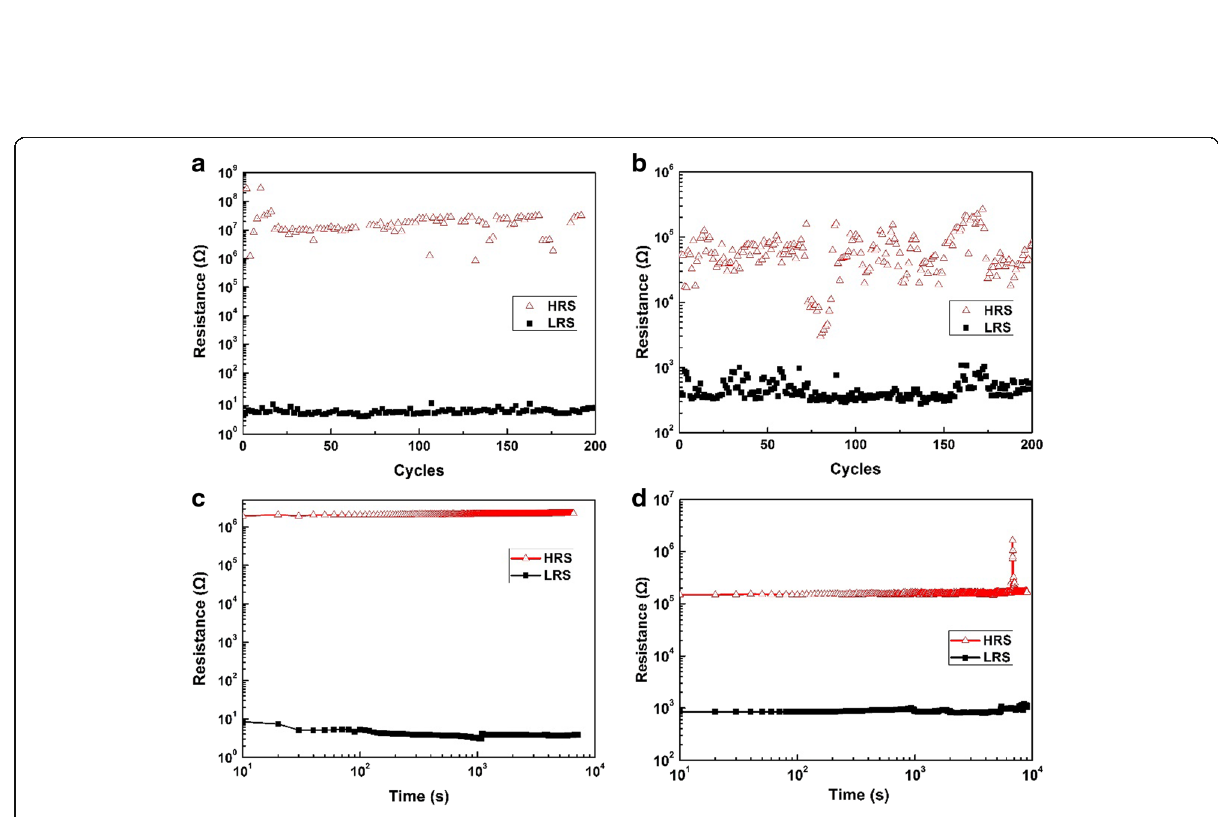
Fig. 4 The endurance and retention characteristics of the device units. a , c Pt/HfO 2 /TiO 2 /HfO 2 /Pt. b , d Pt/HfO 2 /TiO 2 /HfO 2